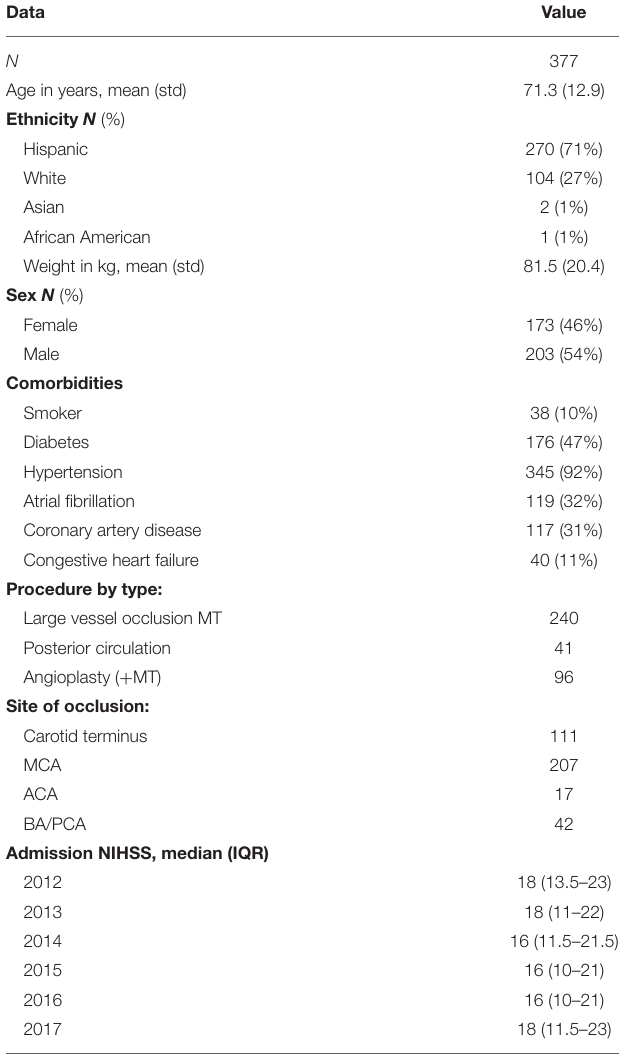
TABLE 1 | Population